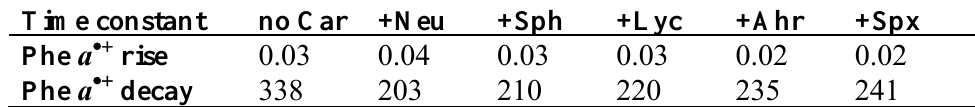
Table 4. Time constants (in ps) determined by the SVD and global-fitting analyses (reprinted from [17], Copyright (2005), with permission from